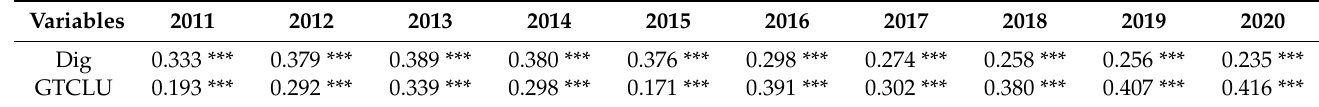
Table 8. Spatial autocorrelation